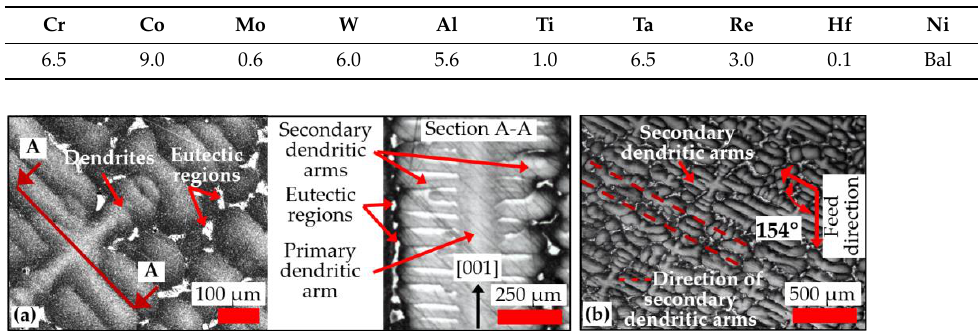
Table 1. Nominal composition (%weight) of single-crystal CMSX-4 Ni-based superalloy.